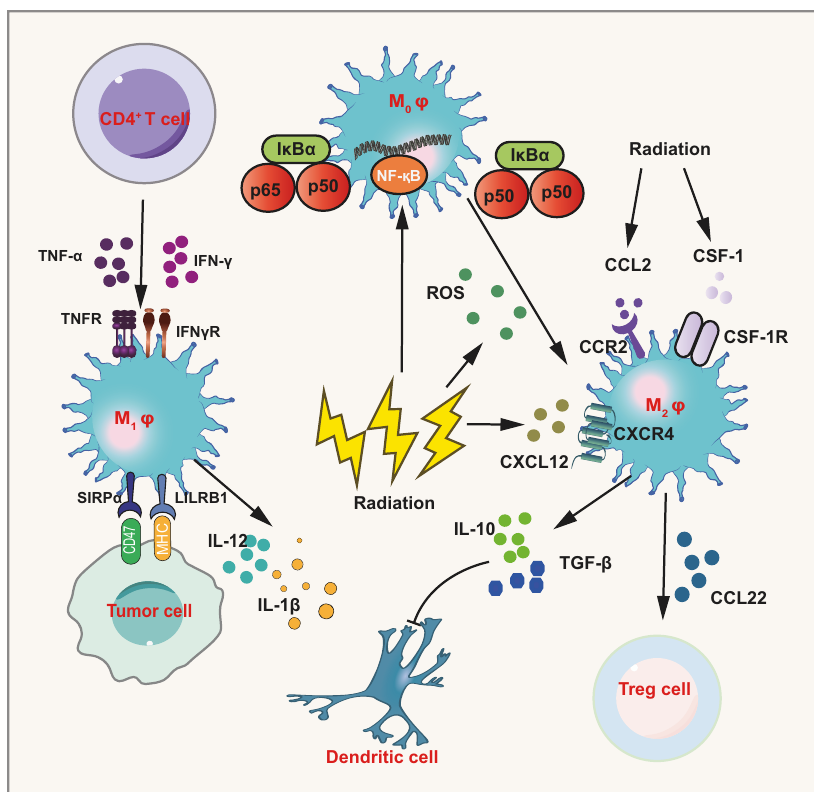
Fig. 4 Immunomodulatory effect of radiation on TAMs. Under the effect of p50 – p50 NF κ B homodimer induced by radiation, M2 macrophages acquired their phenotype. Meanwhile, increased ROS caused by radiation also promotes the polarization to M2 macrophage. The activation of p50 – p50 dimer promotes the conversion towards M2 phenotype, leading to the secretion of IL-10 and TGF- β which inhibit DCs. And CCL22 secreted by M2 macrophage also recruits Treg cells to exert immunosuppressive function. Radiation elicits a high recruitment of TAMs through CCL2/CCR2 and CSF1/CSF1R pathways. And it can also recruit TAMs to in fi ltrate tumor sites, especially hypoxia sites through SDF-1/CXCR4-dependent signaling pathways. Moreover, M1 macrophage ban be activated by CD4 + cells through TNF and IFN- γ and then kill tumor cells via phagocytosis which